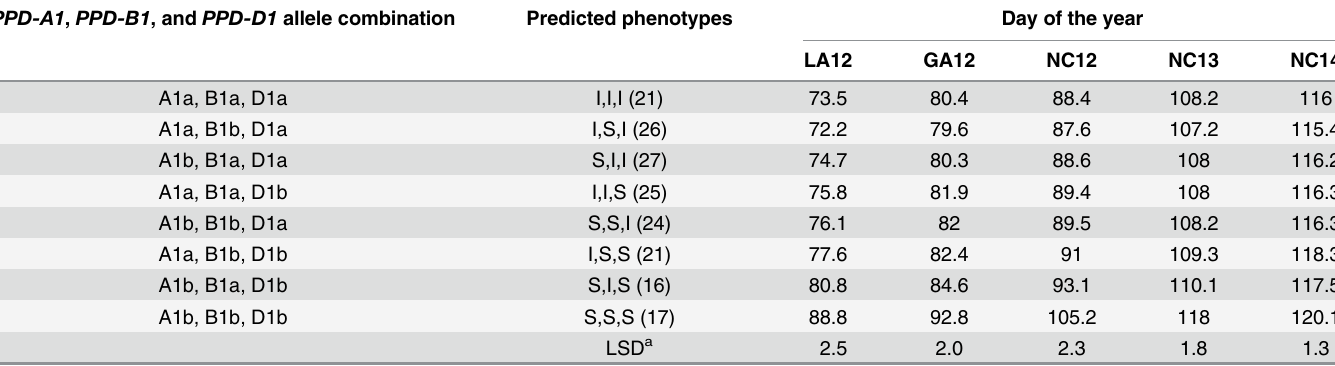
Mean heading dates for AGS 2000 × 26R61 recombinant inbred lines having different PPD1 gene combinations when grown at Baton Rouge, LA, 2012; LA12, Plains, GA, 2012; GA12 Raleigh, NC, 2012; NC12, 2013; NC13, 2014; NC14. Alleles with "a" designation confer day length insensitive phenotype (I) and "b" alleles are associated with day length sensitivity (S). a LSD = Least signi fi cant difference ( p <